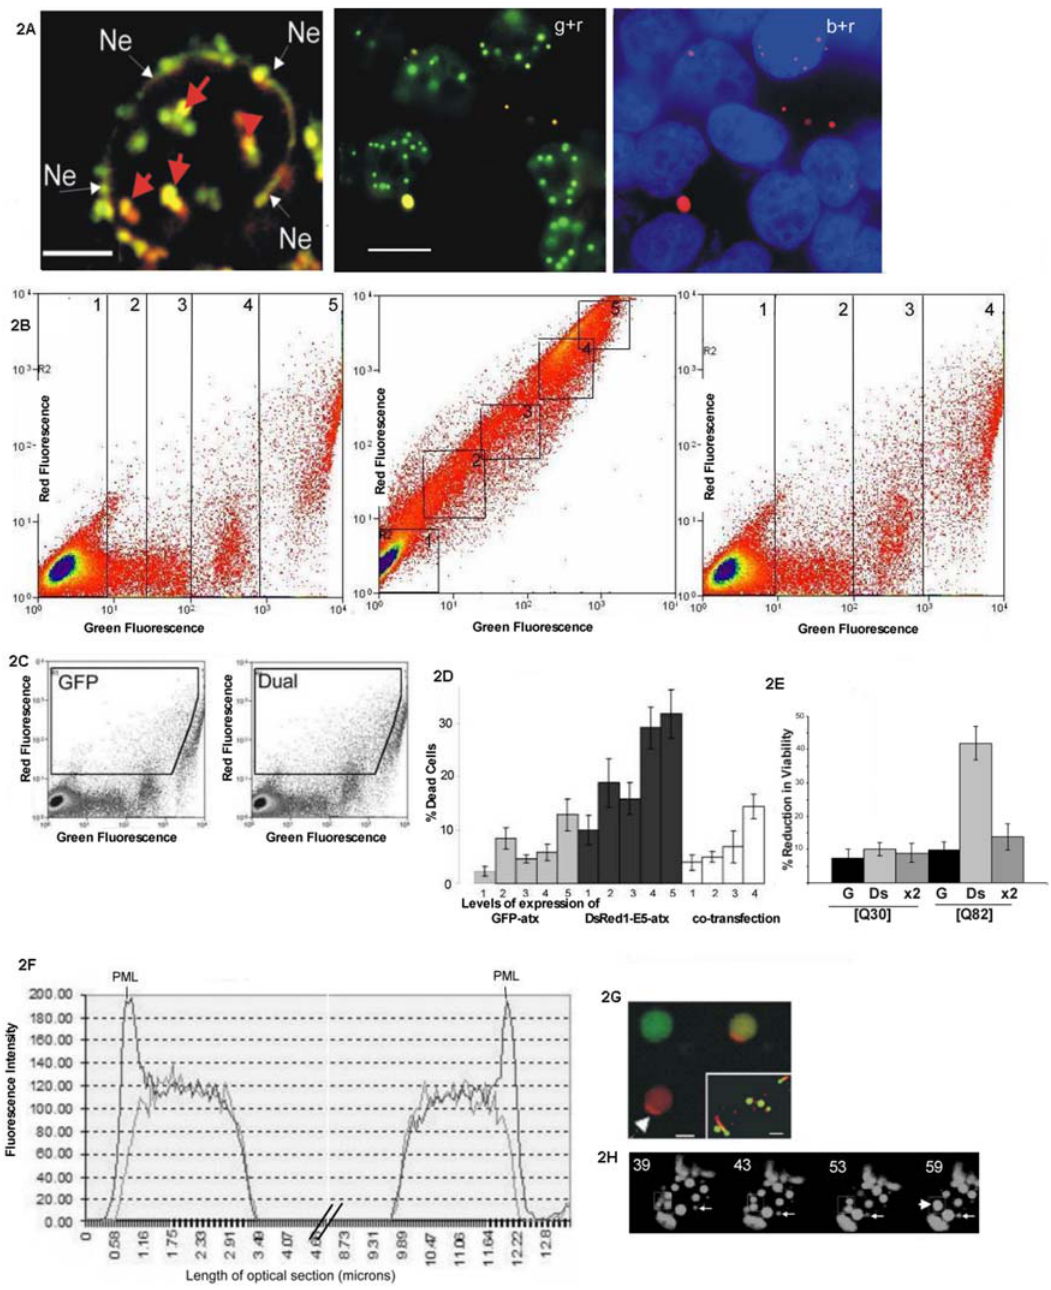
Figure 2. IB properties and lethality of ataxin-1 fusion proteins. Figure 2A. Distribution of DsRed1-E5-PML and dual transfected ataxin-1 fusions. LH panel; puncta of DsRed1-E5-PML reveal heterogeneous red/green fluorescence (arrowed) in a HeLa transfectant. Ne denotes nuclear envelope. Scale bar: 8 microns. RH panel; cytoplasmic enrichment of aged DsRed1-E5-ataxin in dual transfectants. Green and red indicates the wavelengths scanned in each micrograph, with DAPI co-stain. Scale bar: 15 microns. Figure 2B. Red/green fluorescence in single and co-transfectants of ataxin-1 fusion proteins. LH panel; GFP-ataxin-1; Middle panel; DsRed1-E5-ataxin-1; RH panel; dual transfectants. Figure 2C. Enriched red fluorescence in co- transfectants occurs in the region indicated. Figure 2D. Dye uptake shows increased lethality of DsRed1-E5-ataxin-1. Increased DAPI uptake is seen in DsRed1-E5-ataxin-1 versus GFP-ataxin-1 and Dual transfectants. Figure 2E. Cell proliferation assay shows reduced viability in DsRed1-E5-ataxin-1 transfectants. MTT based assay of DsRed1-E5 (Ds), GFP (G) and dual (x2) transfectants, comparing ataxin-1 expressing both normal [Q30] and expanded polyQ repeats [Q82]. Figure 2F. PML-NDs are sequestered by IBs of DsRed1-E5-ataxin-1. Histogram of red/green fluorescence across a DsRed1-E5-ataxin-1 transfectant, stained with N19. Spikes of red fluorescence (darker line) denote PML-NDs tethered to IBs in a single nucleus. Figure 2G. PML/DsRed1-E5-ataxin-1 sequestration. Scale bar: 8 microns. Inset; ataxin-1/PML sequestration captured by immunofluorescent staining of endogenous PML (red) with GFP-ataxin-1. Scale bar: 15 microns. Figure 2H. Mobility of DsRed1-E5-ataxin-1 IBs revealed by time-lapsed confocal microscopy. 9-section Z series were collected every 5 minutes for an hour. The four frames shown indicate fusion events over twenty minutes in a single optical section. Multiple fusion events occur within the boxed region. The arrowed IB also tracks towards this region. The disordered fluorescence at the extremities of the nucleus corresponds to cytoplasmic material.